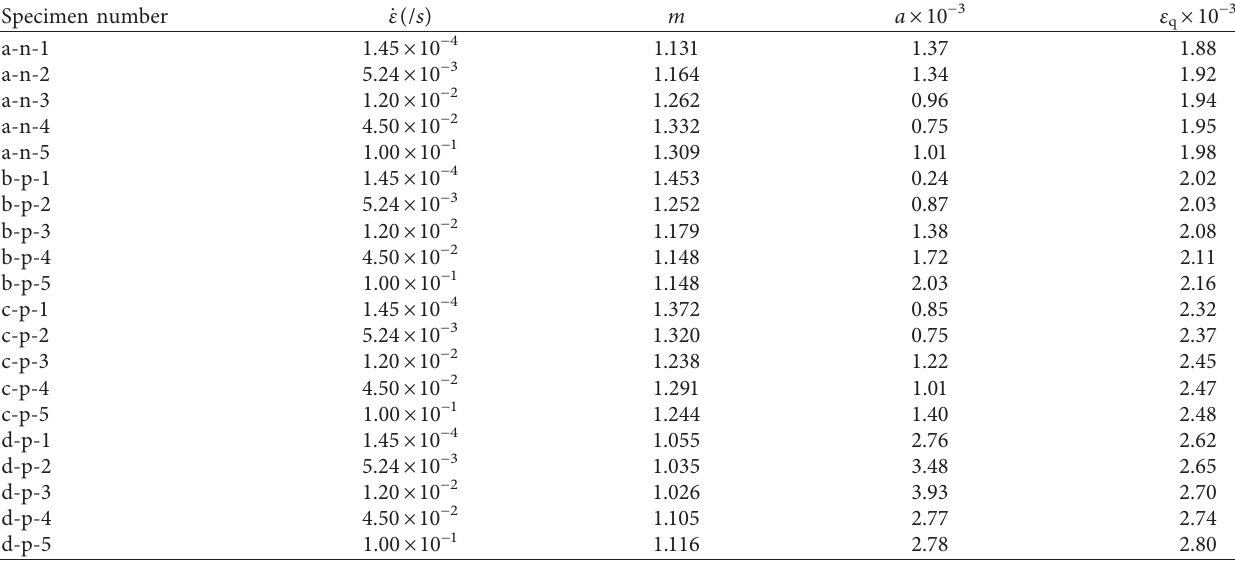
Figure 12: The variation of toughness ratio with strain rate: (a) the variation of toughness ratio with strain rate relative to plain concrete; (b) the variation of toughness ratio with strain rate relative to FRC at _ ε � 1 . 45 × 10 − 4 /s. Table 7: Damage parameters of